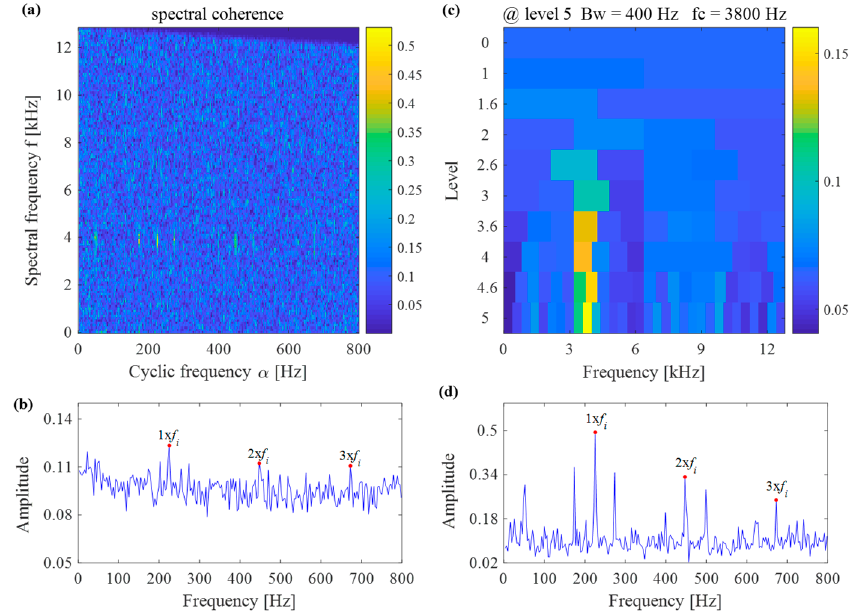
Figure 5. The EES and IEES results of the signal as shown in Figure 4a. ( a ) Spectral coherence of the signal as shown in Figure 4a. ( b ) EES of the signal as shown in Figure 4a. ( c ) Optimal frequency band analysis result of the signal as shown in Figure 4a. ( d ) IEES of the signal as shown in Figure 4a.